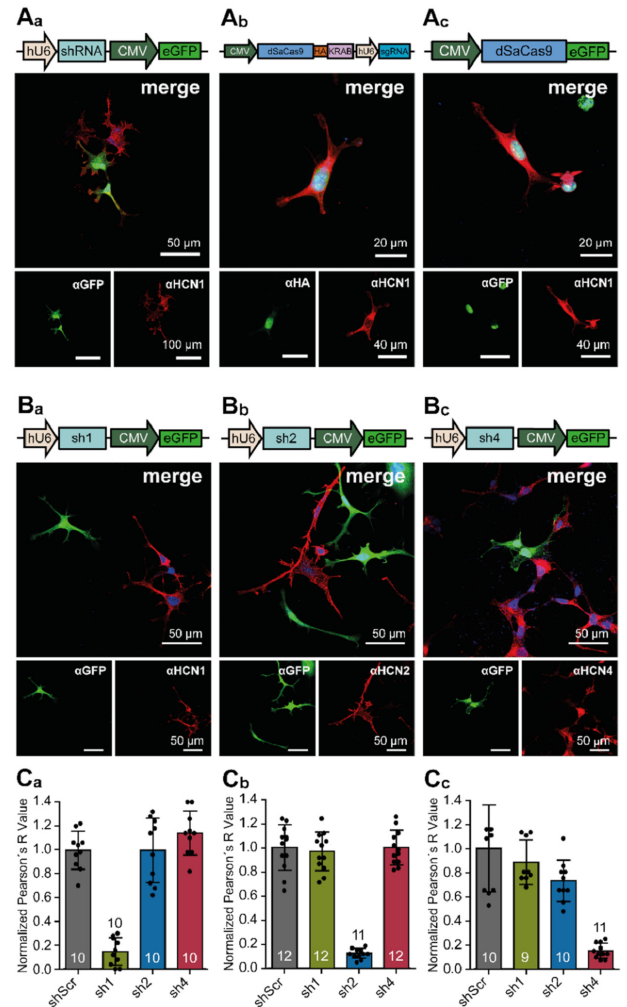
Figure 2. Expression of RNAi- and Clustered Regularly Interspaced Short Palindromic Repeats inter- ference (CRISPRi)-mediating constructs in HEK293 cells. ( A a – A c ) Representative immunofluores- cence images showing the expression of the ( A a ) eGFP reporter of the RNAi construct, ( A b ) dSaCas9 protein including the KRAB domain and the sgRNA expression scaffold, and ( A c ) eGFP-tagged dSaCas9 in HEK293 cells constitutively expressing the hyperpolarization activated and cyclic nucleotide-gated (HCN) channel isoform 1 (HCN1). The eGFP, HA-tag, and HCN1 proteins were im- munostained with specific antibodies. ( B a – B c ) Representative immunofluorescence images showing the expression of ( B a ) the eGFP reporter of sh1-expressing, ( B b ) sh2-expressing, or ( B c ) sh4-expressing variants in HEK293 cells constitutively expressing HCN channel isoforms 1, 2, or 4. Staining was performed with specific anti-eGFP, anti-HA-tag, and anti-HCN antibodies combined with fluo- rescently labeled secondary antibodies (green and red). Nuclei were labeled with TOPRO (blue). ( C a – C c ) Colocalization analysis by comparison of Pearson’s R values for HEK293 cells ( C a ) constitu- tively expressing HCN1 channels and different shRNAs (shScr, sh1, sh2 and sh4), ( C b ) constitutively expressing HCN2 channels and different shRNAs (shScr, sh1, sh2 and sh4), and ( C c ) constitutively expressing HCN4 channels and different shRNAs (shScr, sh1, sh2 and sh4). The data were obtained from indicated numbers of fluorescent images from at least five independent transfections. Pearson’s R values were normalized to shScr controls and results are depicted as mean ± standard deviation. Schematic of AAV-delivered constructs are displayed above the merged immunofluorescence